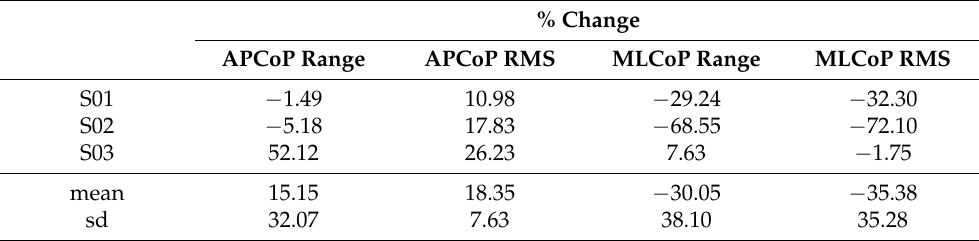
Table 4. Changes in CoP outcomes for three stroke participants after the completion of 4-week core strengthening intervention; sd, standard deviation. APCoP—anterior-posterior center of pressure, RMS—root-mean-squared, MLCoP—medial-lateral center of pressure.